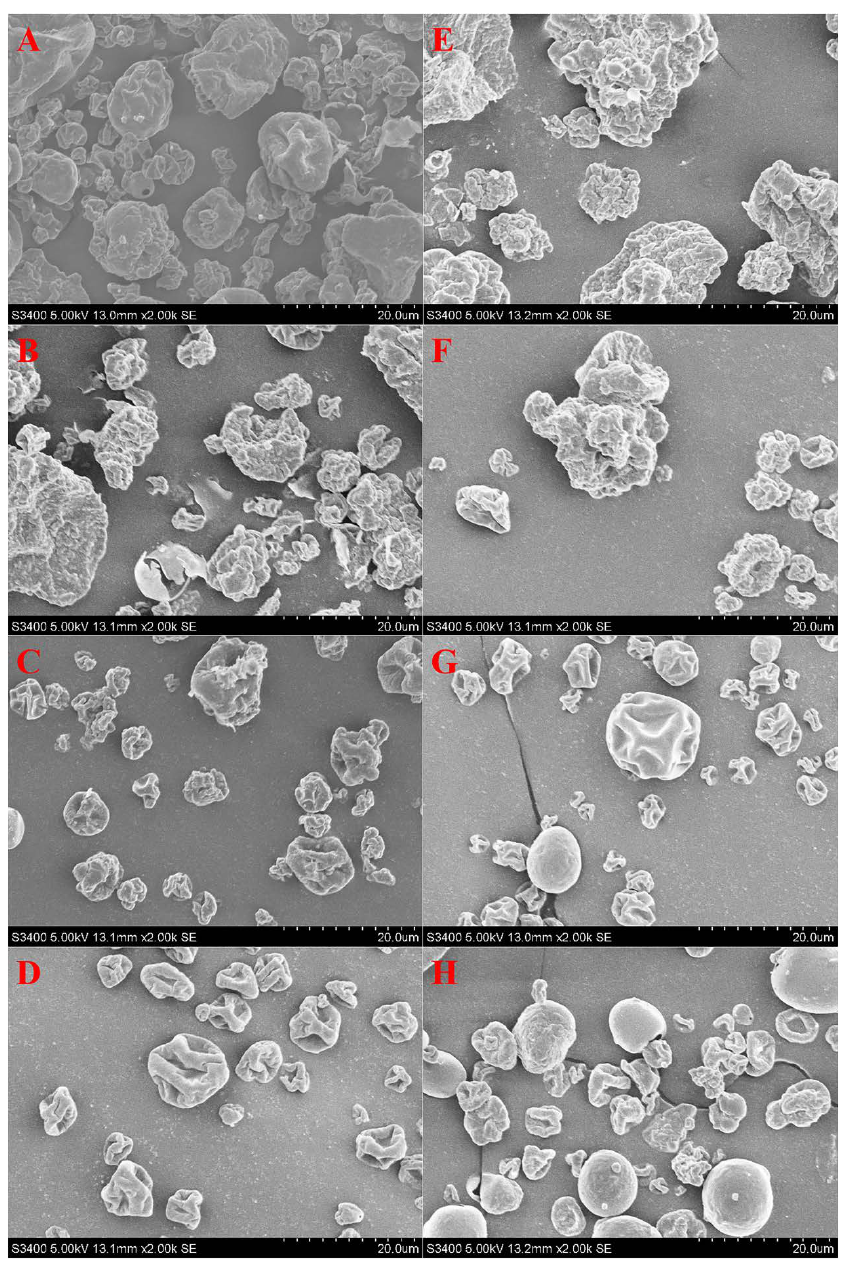
Figure 4. SEM images of SPI pH3 ( A ), SPI pH5 ( B ), SPI pH7 ( C ), SPI pH9 ( D ), SPI/SA pH3 ( E ), SPI/SA pH5 ( F ), SPI/SA pH7 ( G ), and SPI/SA pH9 ( H ) at different pH values.